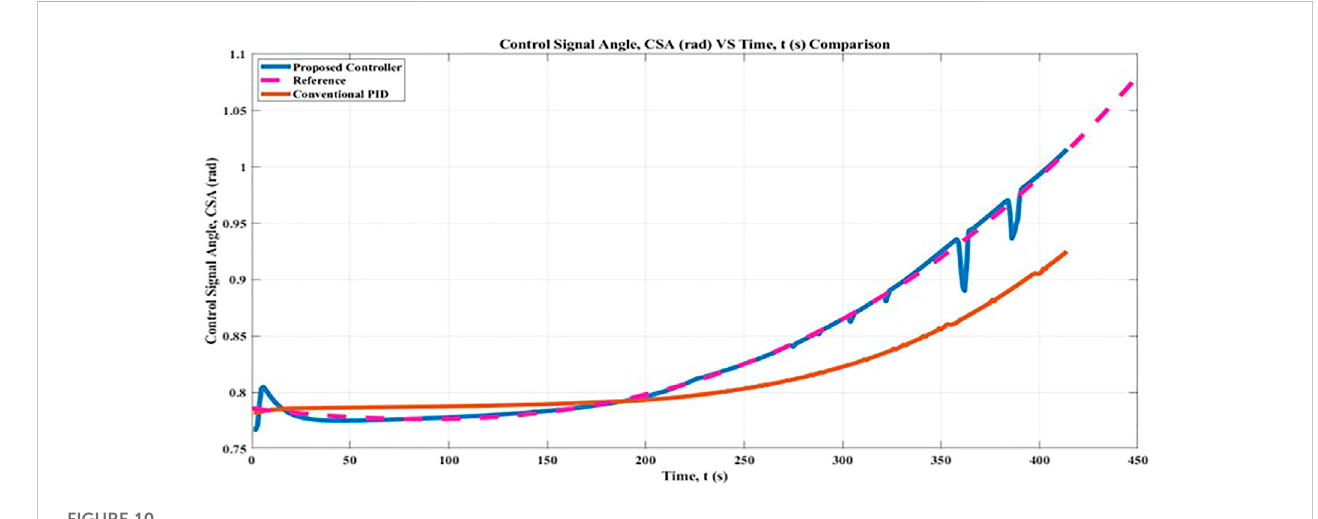
FIGURE 10 Control Signal Angle, CSA comparison result.